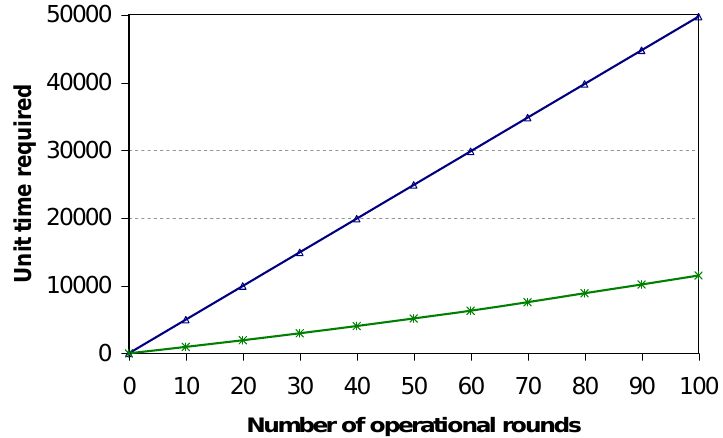
Figure 24. Latency comparison between PEGASIS and the proposed